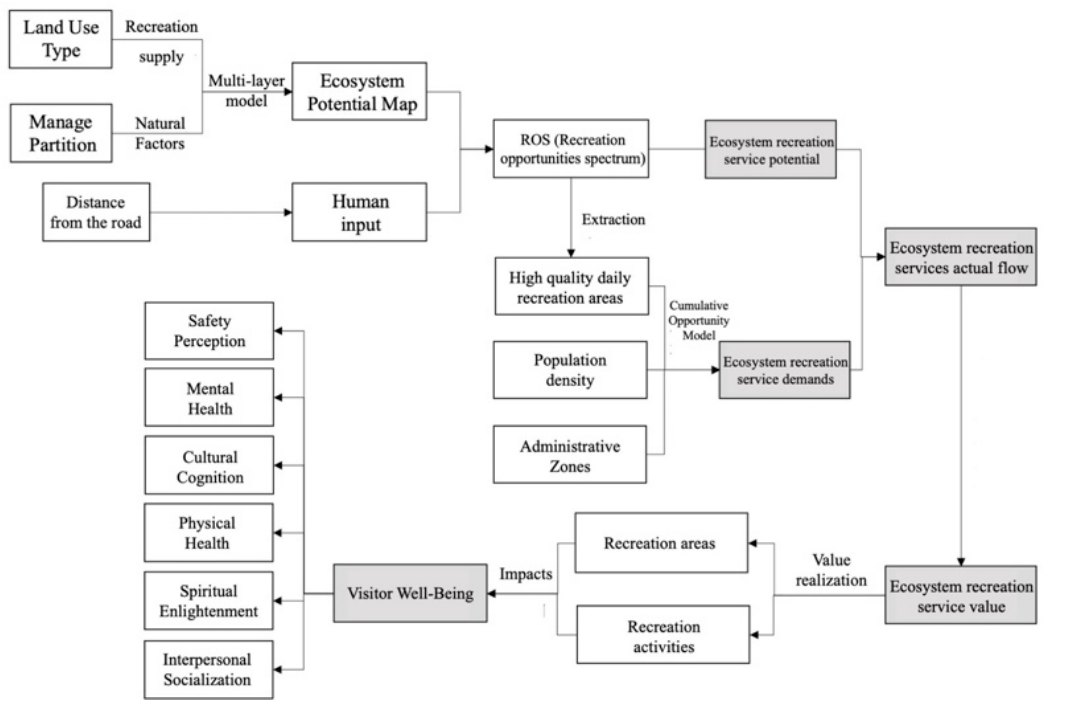
Figure 2. Integrated Assessment Framework for Ecosystem Recreational Services.